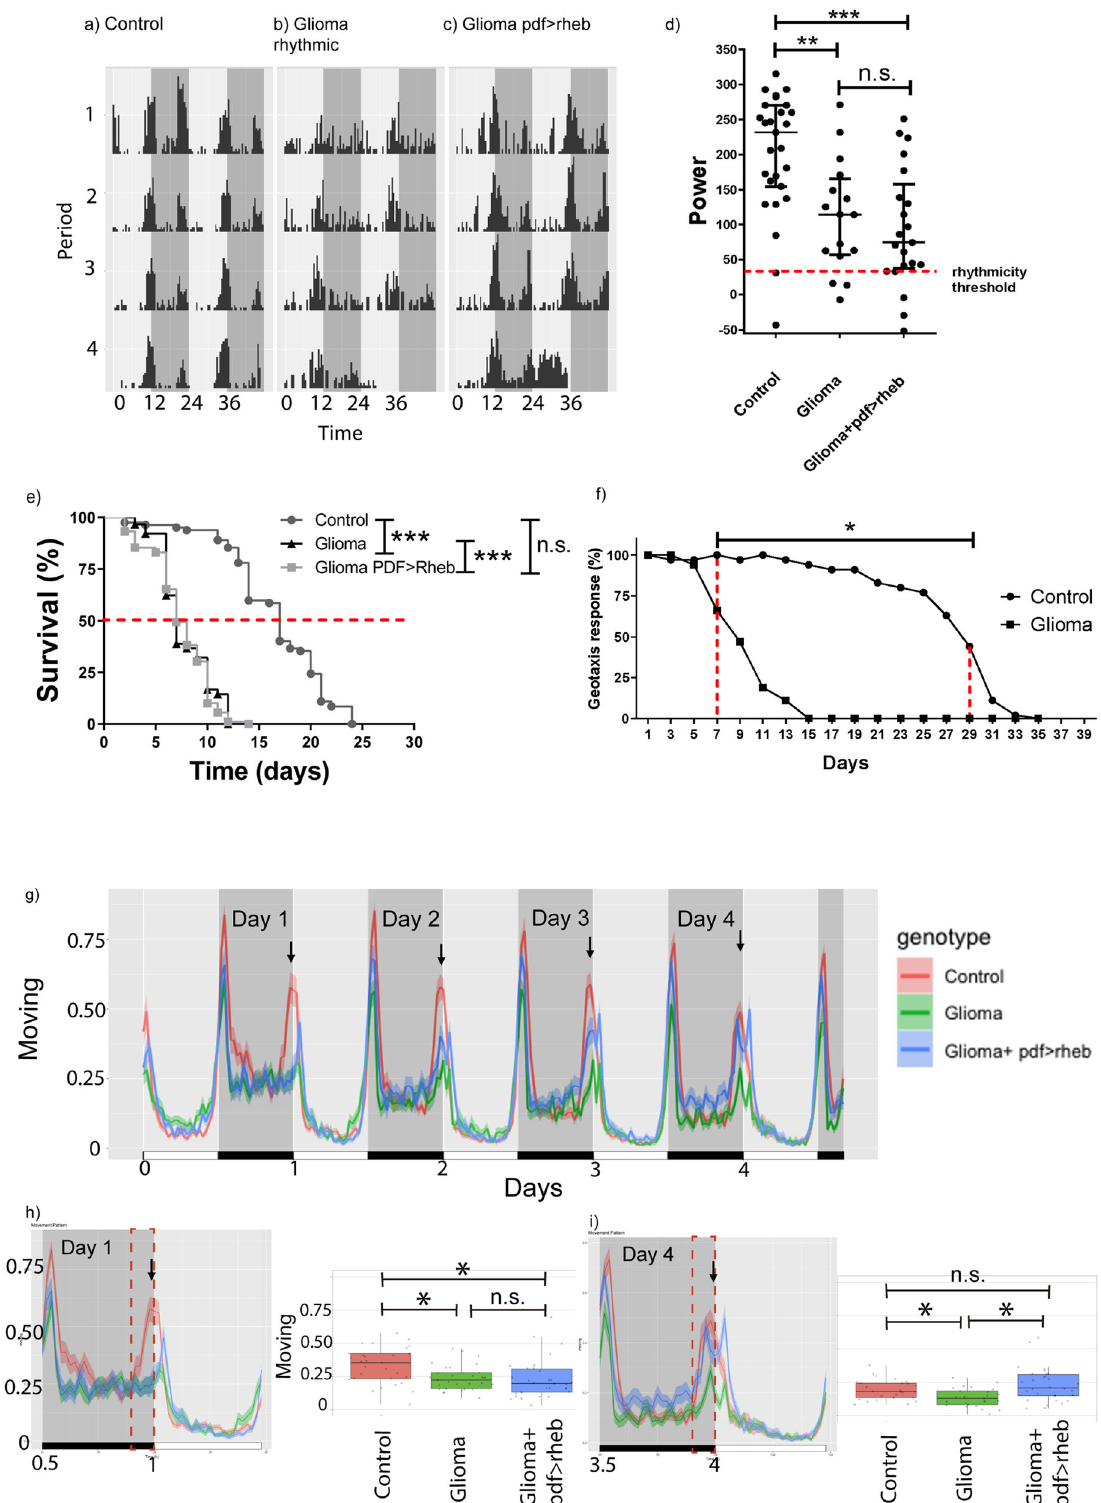
movement at day 7 after tumor induction (Fig. 3f). As a consequence, we focused on early stages of GB development to avoid collateral effects from diminished motility. The morning anticipation (MA, in our case de fi ned as the increased locomotion during 3.5 h before dawn) depends almost